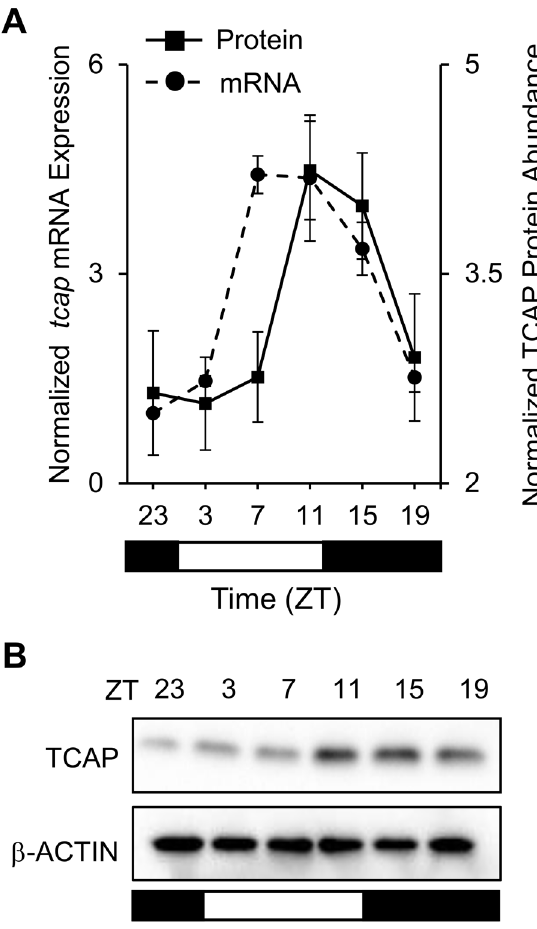
Figure 2. Diurnal cardiac Tcap mRNA and TCAP protein rhythms. Hearts were collected every 4 h across the 12:12 L:D cycle from C57Bl/6N mice, and used for qRTPCR (mRNA) or Western blot (protein) analysis. (A) Tcap mRNA (dotted line) exhibited rhythmic expression (JTK_Cycle, p=7.41 6 10 2 5 ) with a peak in the light phase at ZT07 (murine sleep time) and trough in the dark phase (n=3/time point). TCAP protein (solid line) also exhibited a rhythmic profile (JTK_Cycle, p=0.00139) that peaked in the light and reached a nadir in the dark (n=3/time point). There was a 4 h phase delay between mRNA expression and protein abundance. (B) Representative Western Blot, illustrating TCAP protein abundance over the 12:12 LD cycle. The diurnal environment of 12 h dark (black bars, animal’s subjective wake time) and 12 h light (white bars, animal’s subjective sleep time) is illustrated by the bars below the graphs.